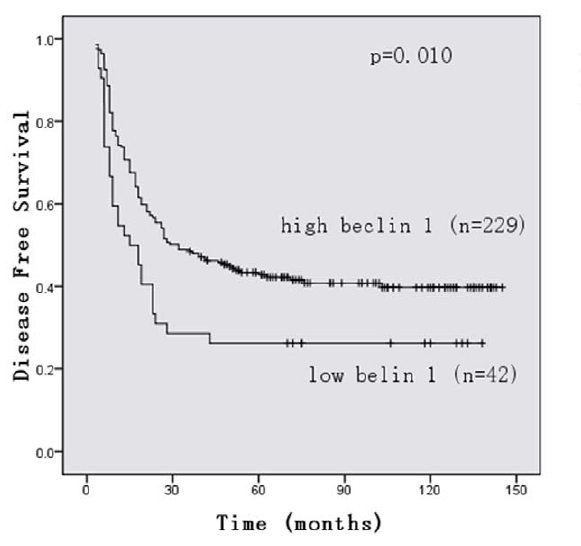
Figure 4. Kaplan-Meier estimates of the probability of disease free survival (DFS). Patients with high expression Beclin 1 showed significantly longer DFS than those with Beclin 1 low expression.